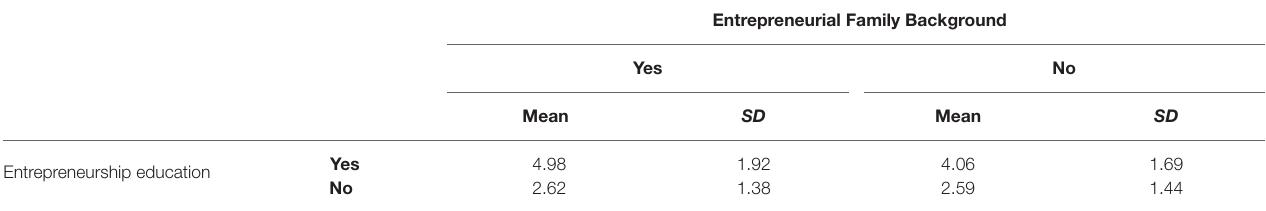
TABLE 4 | Means and standard deviations of founding passion by entrepreneurship education and entrepreneurial family background.